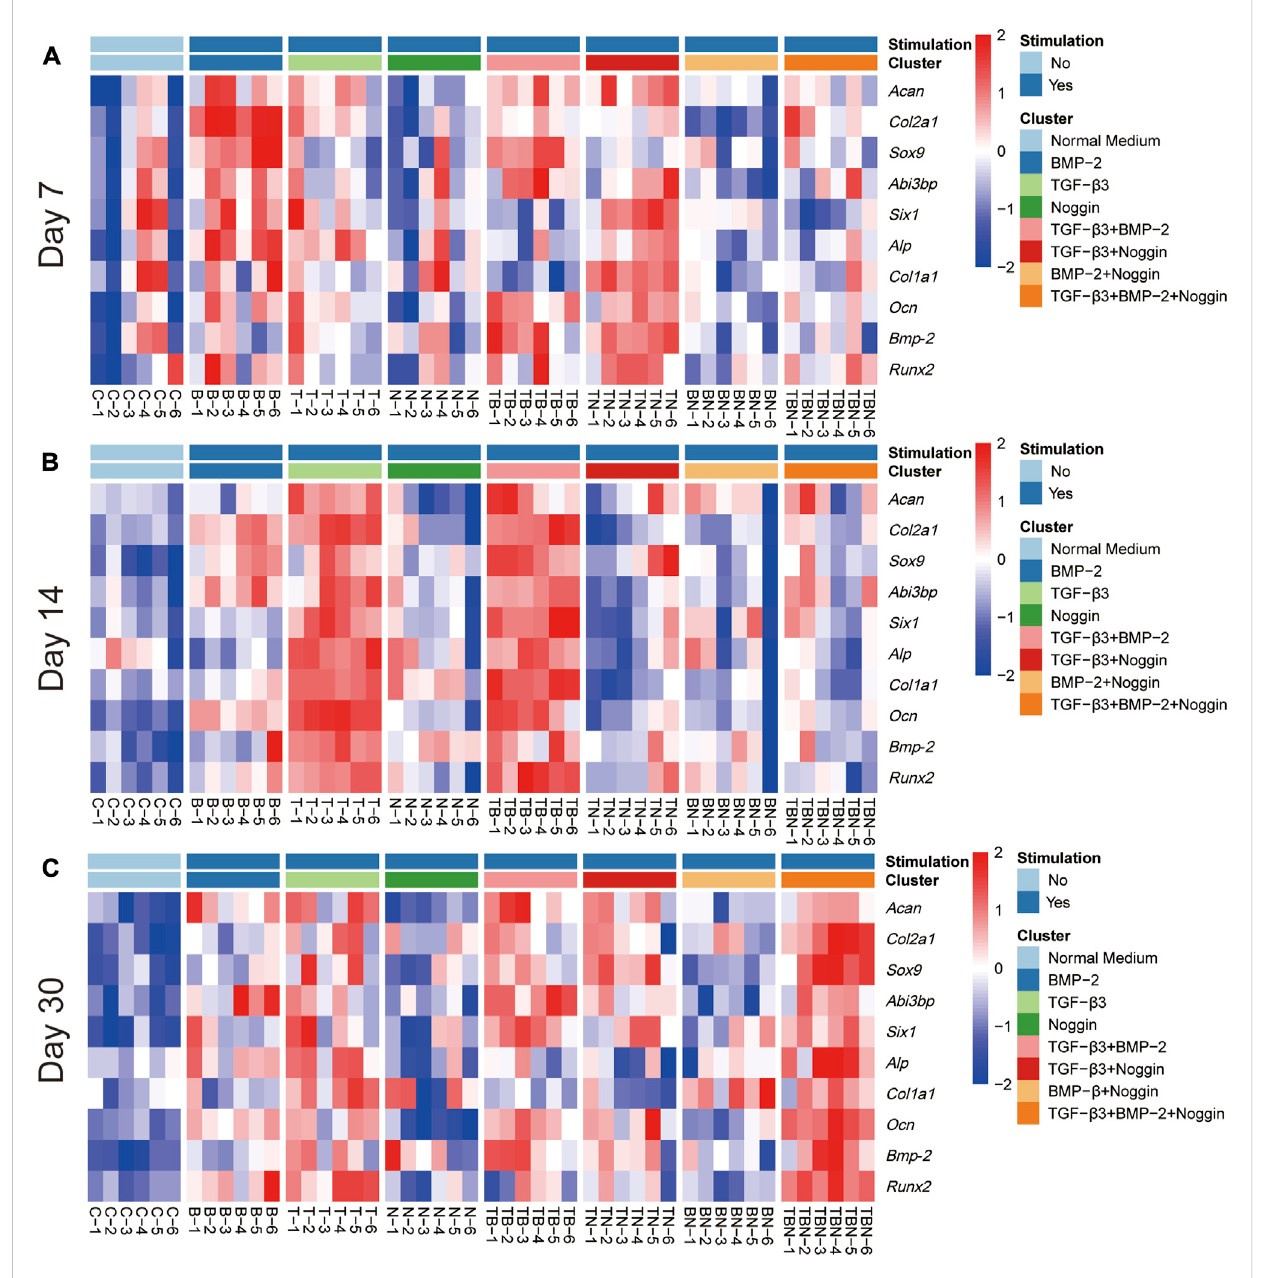
FIGURE 7 Heat mapof gene expression. All relative geneexpressionat7 (A) , 14 (B) and 30 days (C) . Acan =Aggrecan,Col2a1=Collagen type II alpha 1,Sox9 = Sex determining region Y (SRY)-box transcription factor 9, Six1= Six homeobox 1, Abi3bp = Abi family member 3 binding protein, Runx2 = Runx family transcription factor 2, Alp= Alkaline phosphatase, Bmp-2 = Bone morphogenetic protein-2, Ocn = Osteocalcin, Col1a1 = Collagen type I alpha 1 chain ; (n =